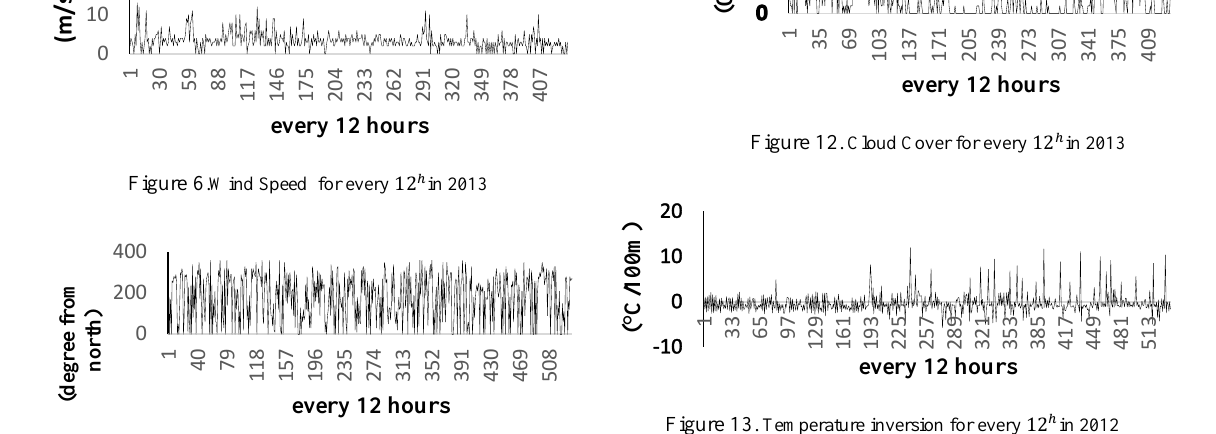
Figure 5 .Wind Speed for every 12 ℎ in 2012